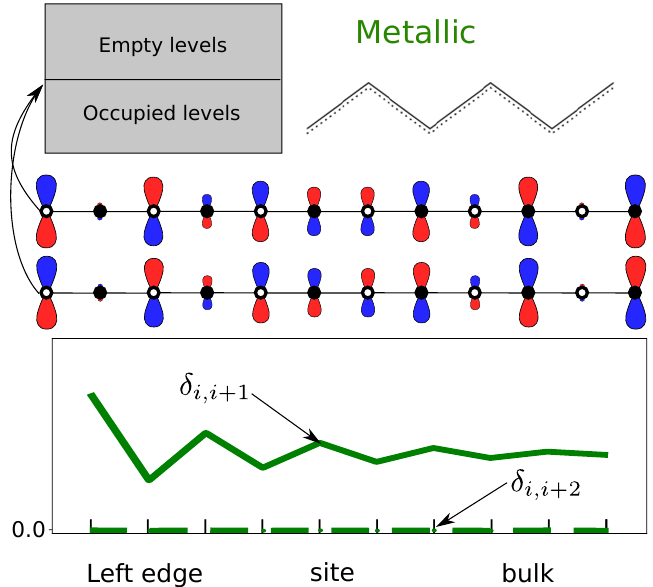
Figure 6. Energy levels, resonance scheme, orbitals around the Fermi level and DIs δ i , i + 1 and δ i , i + 2 of the bipartite lattice in the metallic case. The chain is 80 atoms (only 10 sites are shown) and β = β (cid:48) =